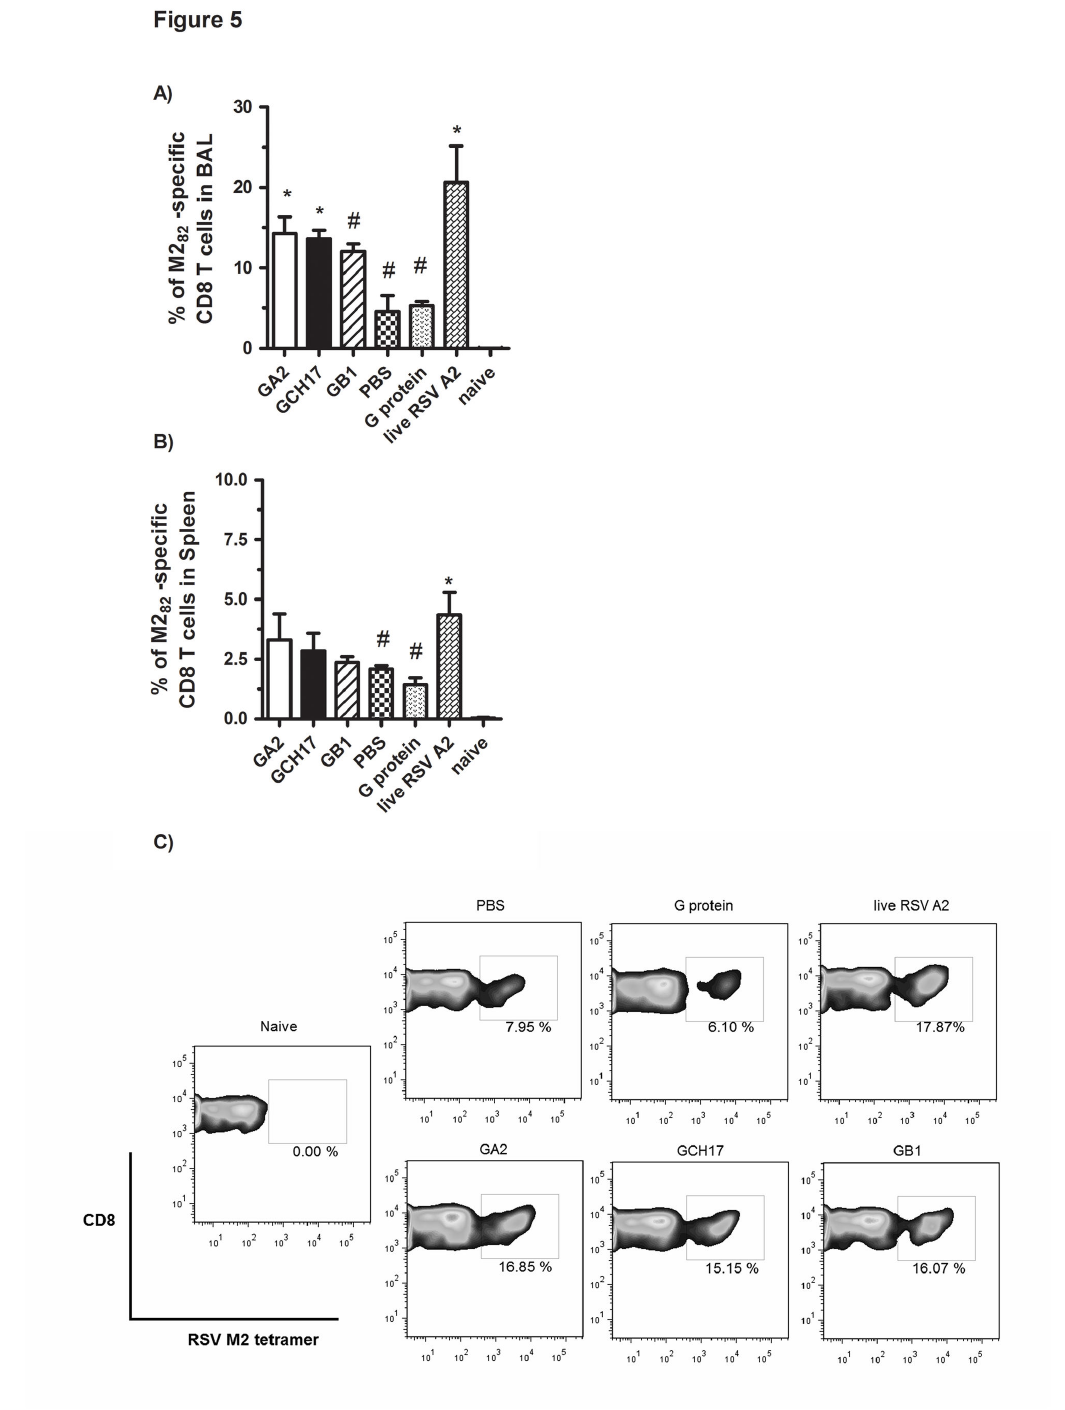
Figure 5. Enumeration of RSV M2-specific CD8 + T cells using MHC class I tetramers. Spleen and BAL cell suspensions obtained from mice challenged with RSV A2 were stained with anti-mouse CD3e PE-Cy7-conjugated, anti-mouse CD8α PerCP- conjugated and APC-labeled M2-specific H-2Kd tetramer. FACS contour plots were gate on CD3/CD8 positive cells. Percentage of M2- H-2Kd tetramer positive CD8 + T cells in BAL (A and C) and spleen (B) are shown. Error bar represents the SEM from n=5 mice per group. *, #, p<0.05, significant difference as determined by one-way ANOVA and Dunnett’s test, compared with PBS vaccinated control mice (*) or compared to live RSV A2 vaccinated mice (#). doi: 10.1371/journal.pone.0074905.g005 PLOS ONE |